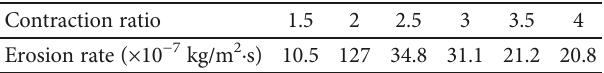
Table 3: Erosion rates of rock at di ff erent contraction